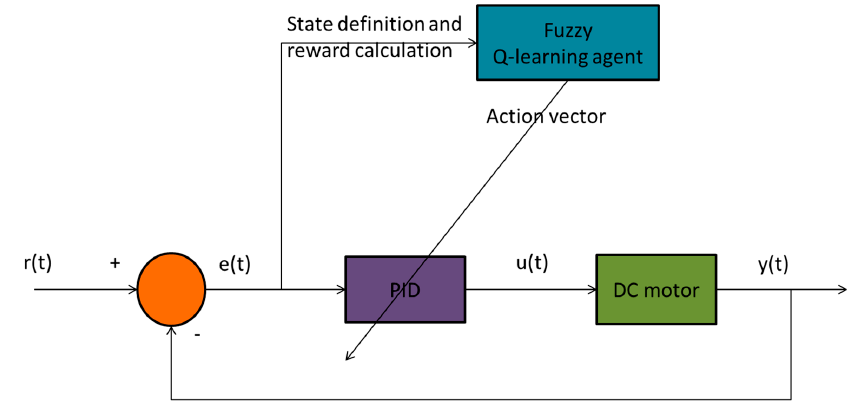
Figure 2. Block diagram of the control strategy.